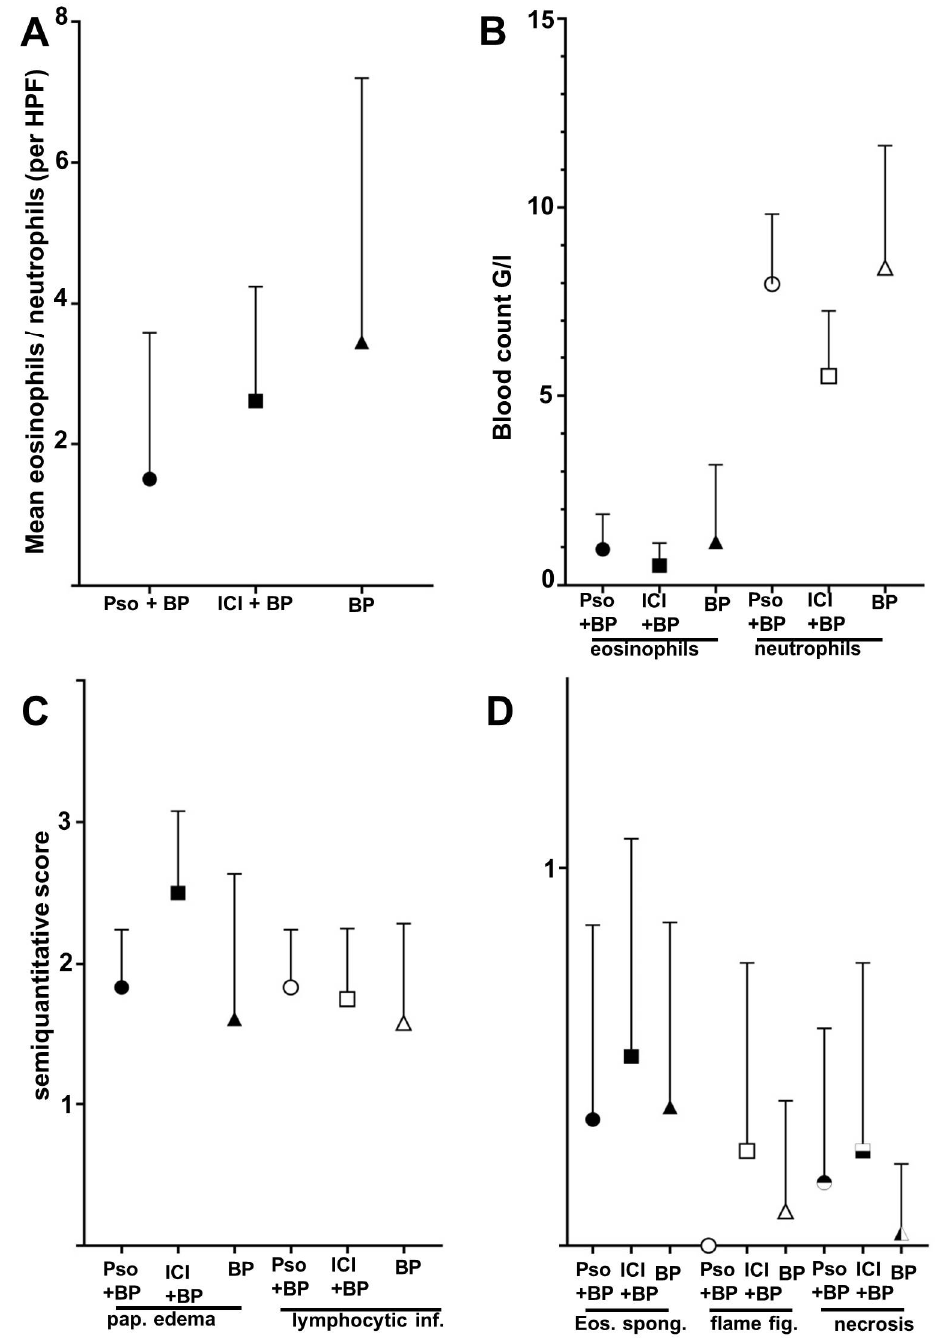
Figure 3. Differences of histolopathologic and laboratory features between the groups of BP in psoriatic patients (Pso + BP), BP in patients receiving immune checkpoint inhibitors (ICI + BP), and the control group of idiopathic BP (BP). Whiskers indicate standard deviation and are shown one-sided only to avoid negative values ( A ). Tissue ratio of eosinophils/neutrophils as assessed as mean of four random high-power fields (HPF) per section. ( B ) Total blood count of eosinophils and neutrophils of the patients at the time of biopsy. ( C ) Semi-quantitative score of papillary edema (pap. edema) and lymphocytic infiltrates (lymphocytic. inf.) (0 = absent, 1 = low, 2 = moderate, 3 = strong). ( D ) Frequency of eosinophilic spongiosis (Eos. spong.), flame figures (flame fig.) and necrosis (0 = absent, 1 = present). None of the shown comparisons reached statistical significance (Mann–Whitney test). The group of idiopathic BP showed both the highest mean number of peripheral eosinophils (1.14 G/L) when compared to psoriatic patients (0.94) and ICB patients (0.54), and also peripheral neutrophils (8.41 G/L, 7.97 G/L and 5.52 G/L, respectively) ( B ). We further evaluated histopathological characteristics of the three groups of BP. Papillary edema as a sign of